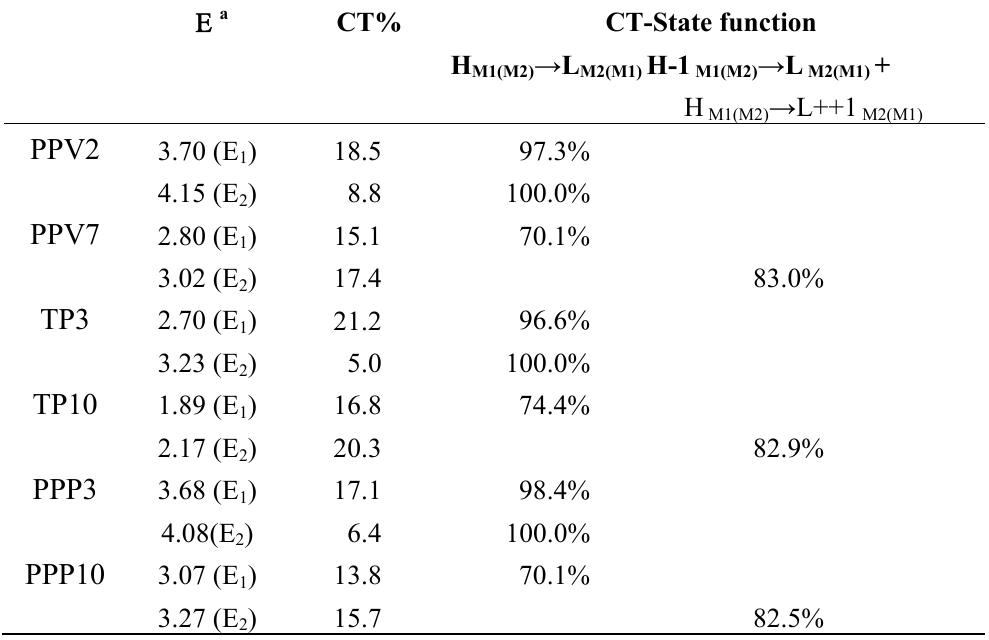
Table 2. Calculated Electronic Transitions and State Functions for Cofacial polymer , OT , OP Dimers Separated by 3.8 OPV n n n